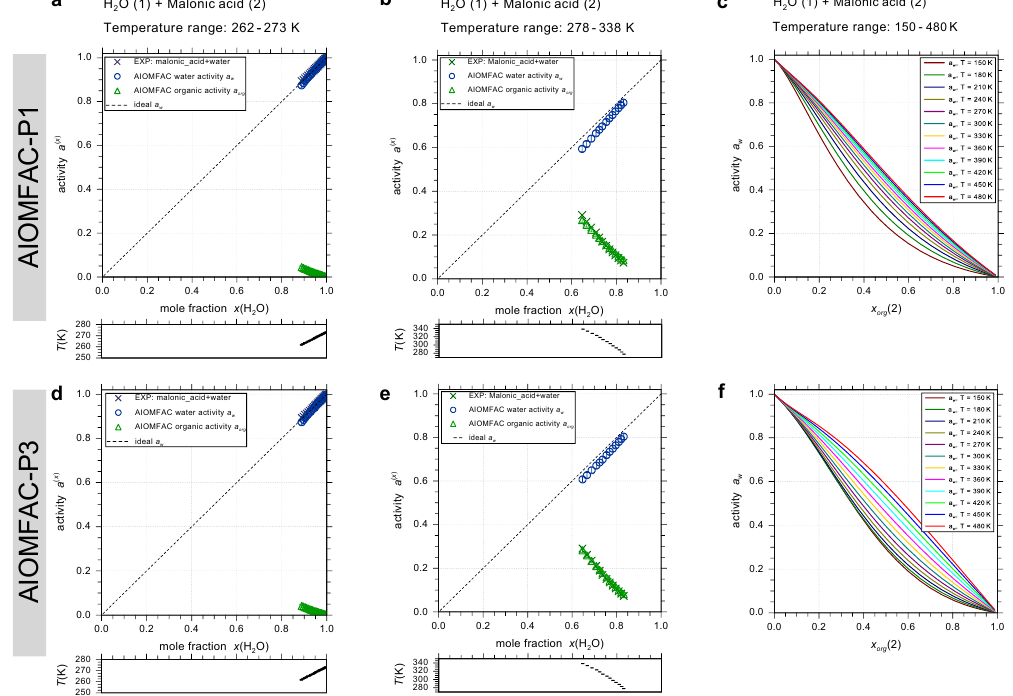
Figure 4. SLE measurements for water (1) + malonic acid (2) solutions and corresponding calculations of AIOMFAC-P1 (a–c) or AIOMFAC-P3 (d–f) . Panels (c, f) show the temperature dependence of water activities predicted for the range 150–480K. (a, d) Low temperature experimental SLE data (crosses) are compared with the predictions for water activity at the same compositions and temperatures (blue circles). Predictions of the corresponding organic activities are shown as well (green triangles) while (b, e) show analogous SLE data for the malonic acid melting curve. The error bars represent the model sensitivity to a composition variation by x tol = 0 . 01. The dashed line represents the hypothetical water activity of an ideal mixture. The temperatures of the individual data points are given in the boxes below the main panels. Experimental data: Braban et al. (2003) and Apelblat and Manzurola